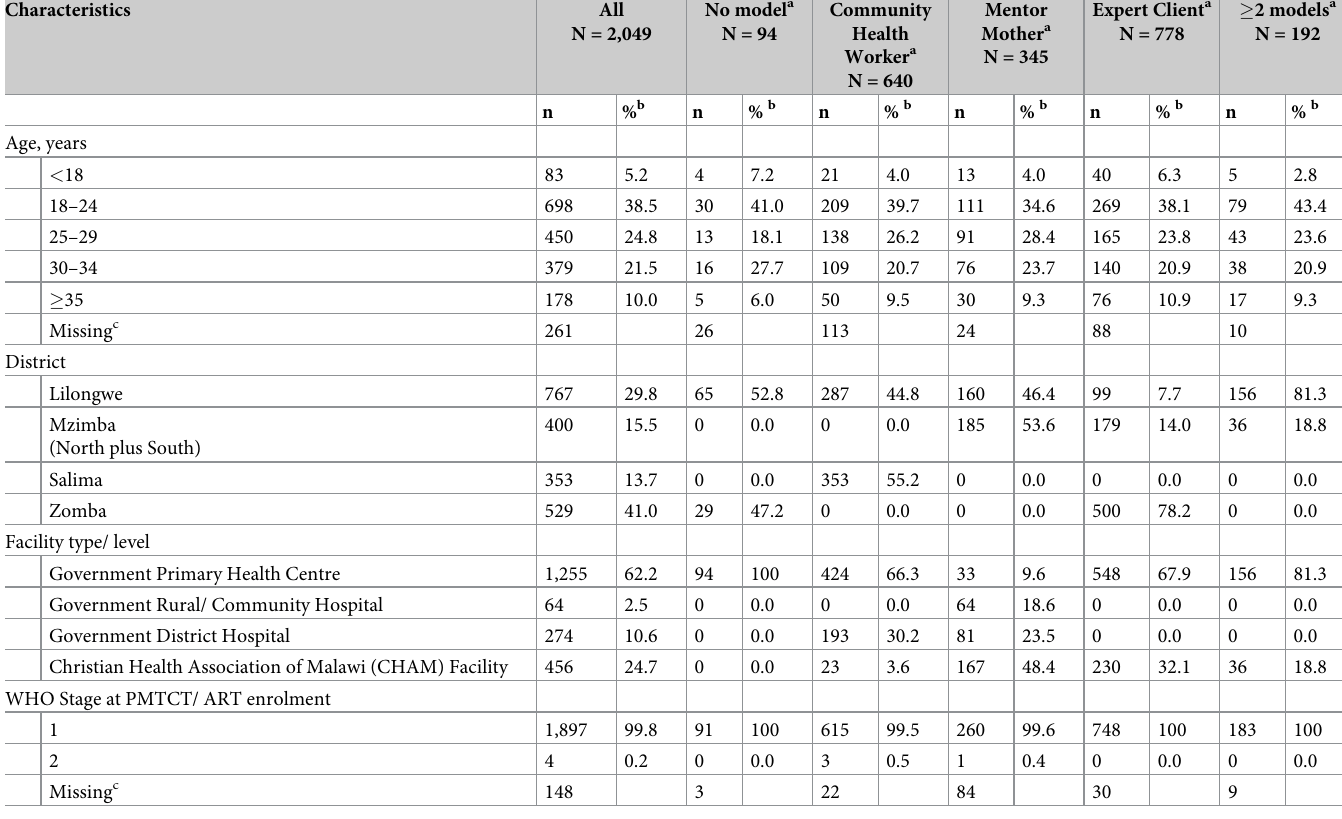
Table 1. Characteristics of PBFW living with HIV in the study cohort by CFL model exposure ( N =